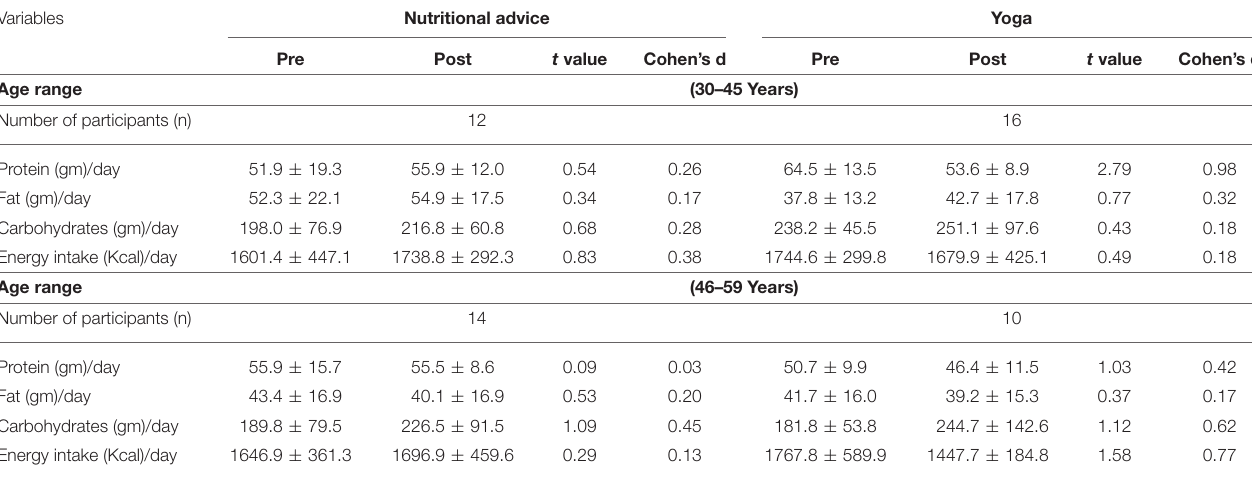
TABLE 10 | Estimated energy intake/day based on 24h diet recall questionnaire for two different age range i.e., 30–45 and 46–59 year. Variables Nutritional advice